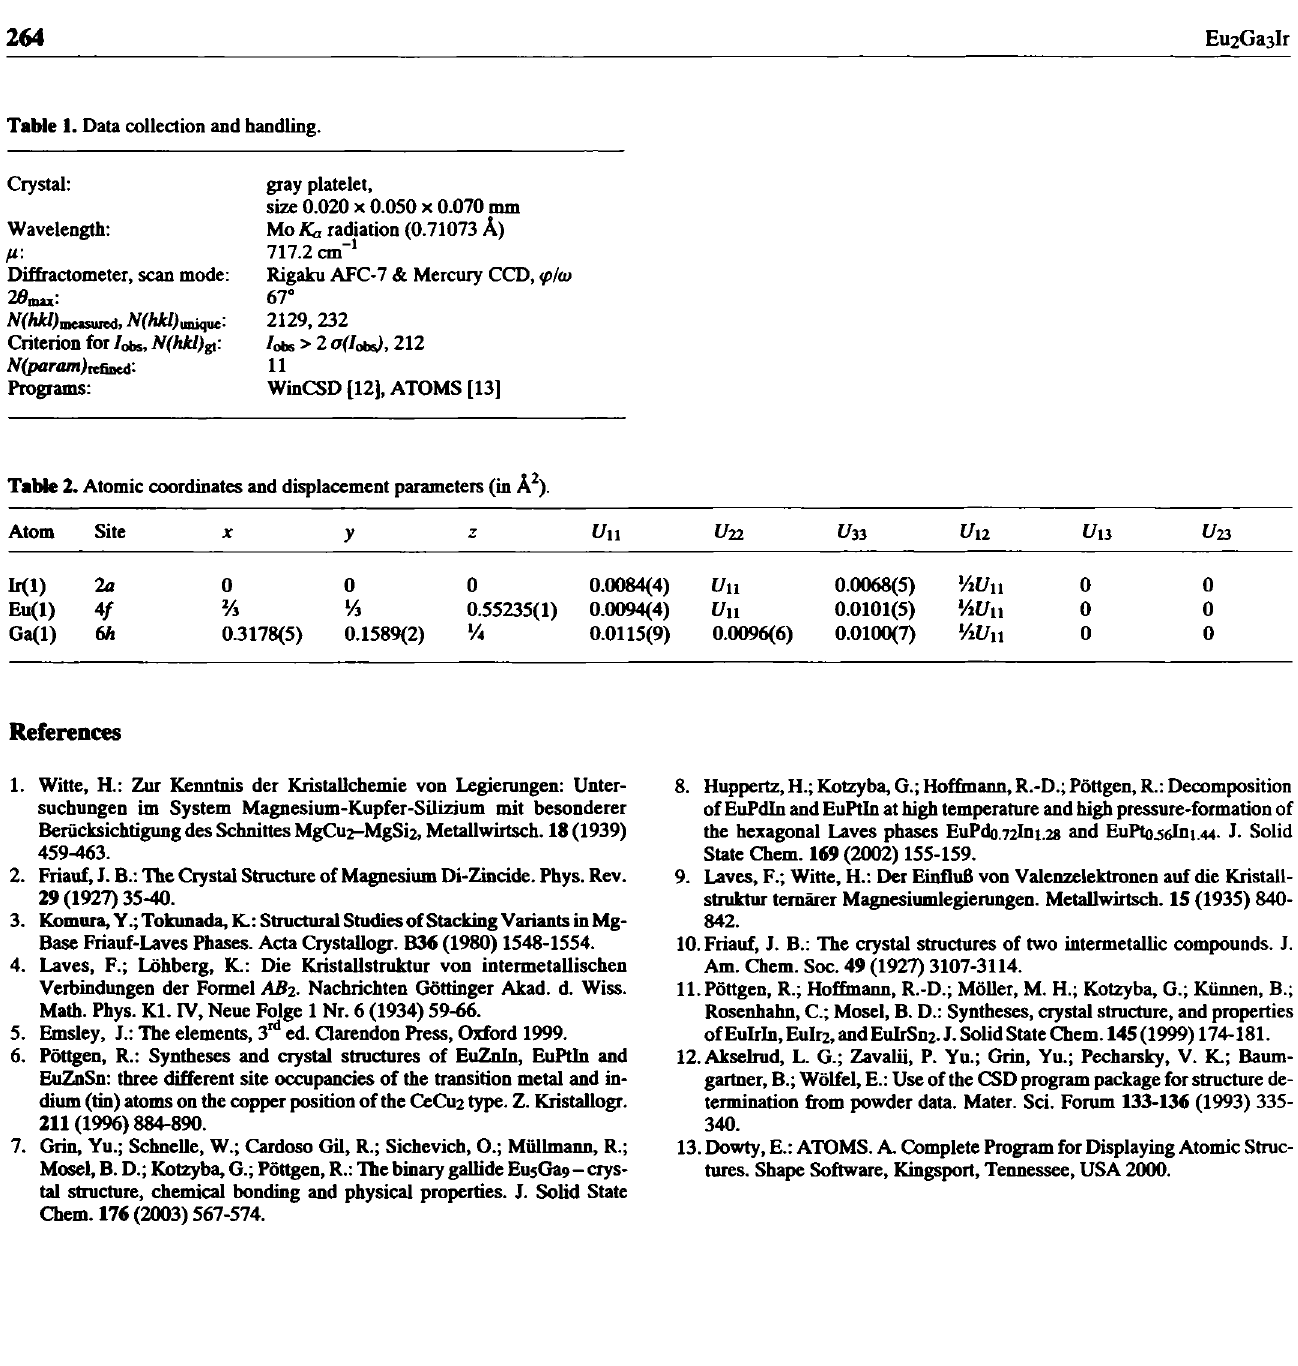
Table 1. Data collection and handling.